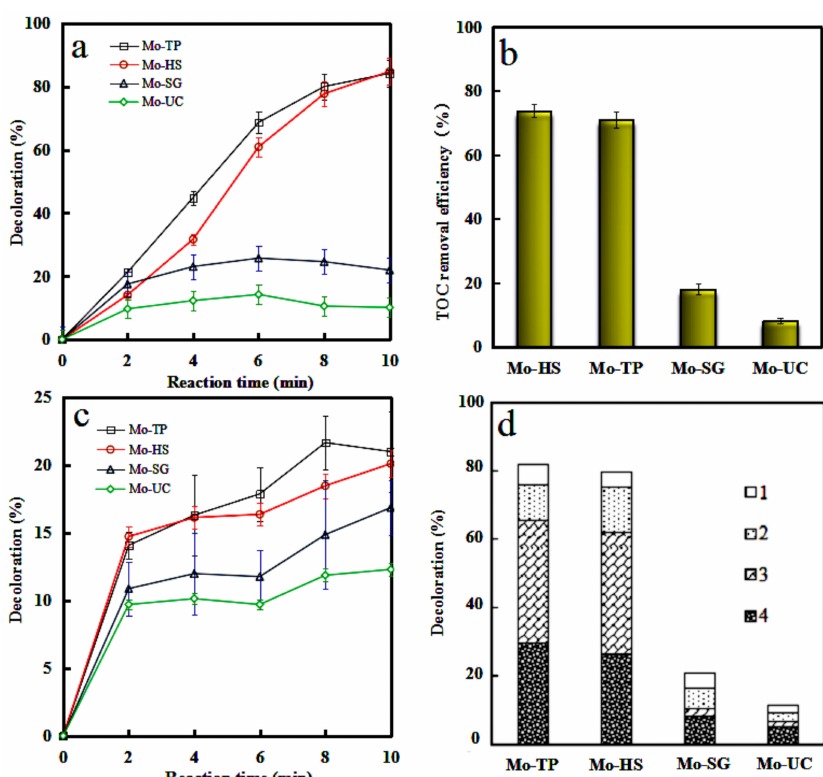
Figure 8. The degradation of Cationic Orchid X-BL ( a , b ) by the Mo/ZnAl-LDH catalysts in catalytic wet air oxidation (CWAO); the adsorption of Cationic Orchid X-BL ( c ) by the Mo/ZnAl-LDH catalysts; the recycling times ( d ) of the Mo/ZnAl-LDH